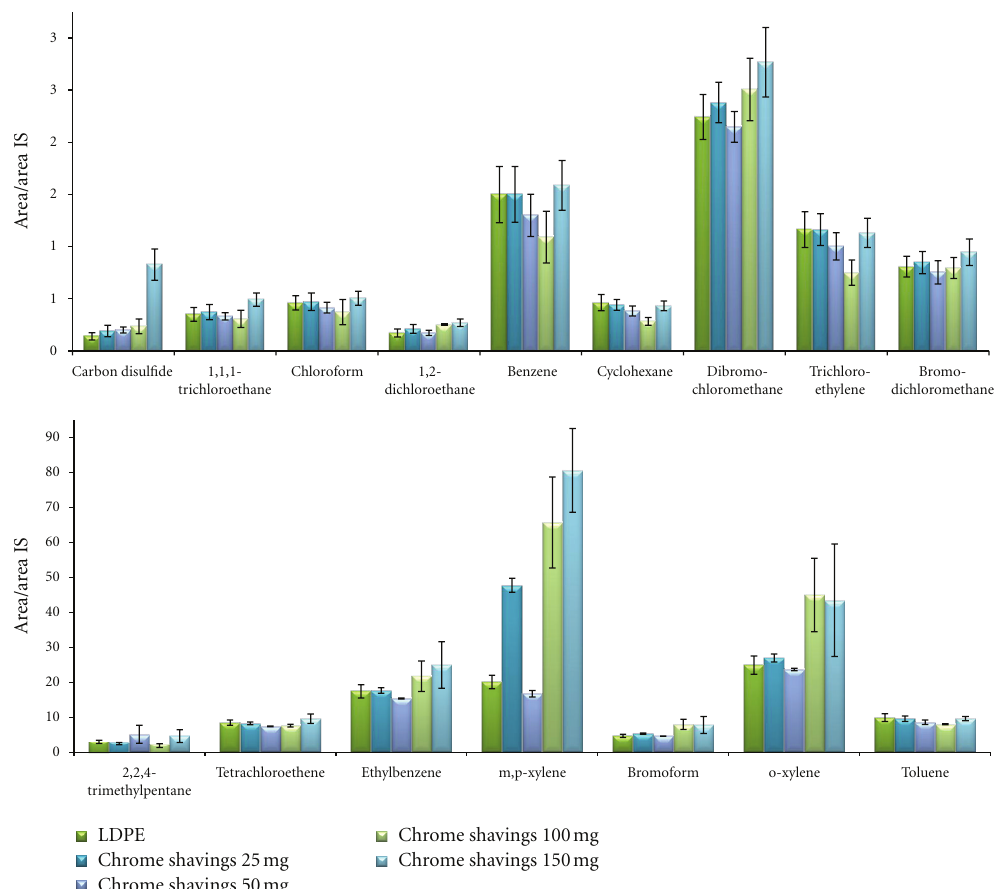
Figure 3: HS-GC-MS relative signals with standard deviations obtained from chrome shaving passive samplers deployed on air spiked with 5.26 mgm − 3 VOCs as a function of the use of di ff erent amounts of chrome shavings and empty LDPE. The deployment time was 24 h in all